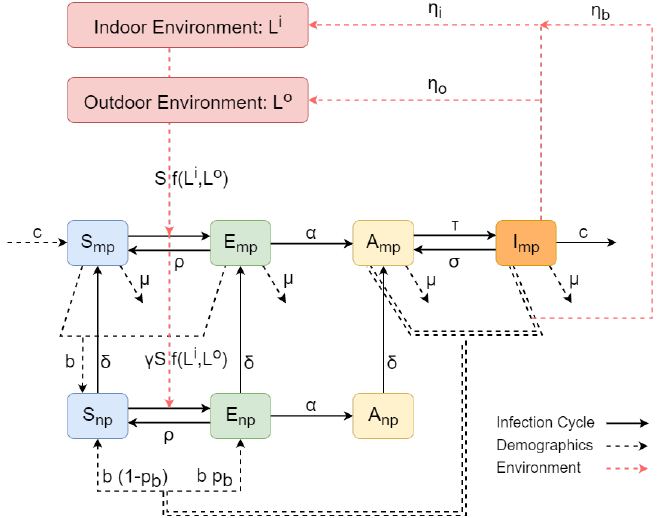
Figure 1. Flow diagram representation of the C. burnetii transmission model. The sub-populations of the model within the nulliparous and multiparous compartments are denoted by rounded squares, ex- cept from the magenta squares that denote the indoors and outdoors environment compartments. The transition rates between the sub-populations are indicated by the black arrows (solid/dashed when related to the infection cycle/demographics) with their associated parameters. The dashed red arrows denote transition rates incorporating contributions from/to the